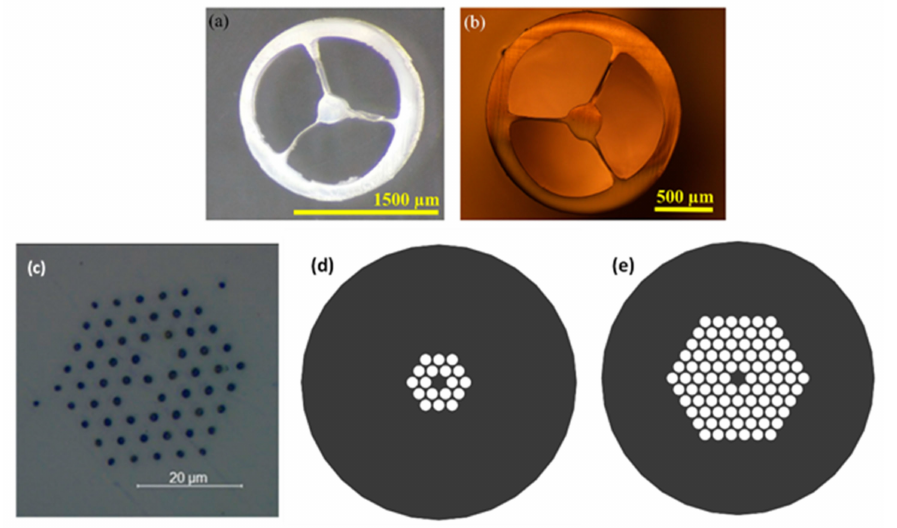
Figure 2. ( a – c ) Microscope images of the fiber cross-section of mPOF with different diameters. Reproduced with permission: ( a , b ) from Ref. [64]; ( c ) from Ref. [65]. ( d , e ) images of the